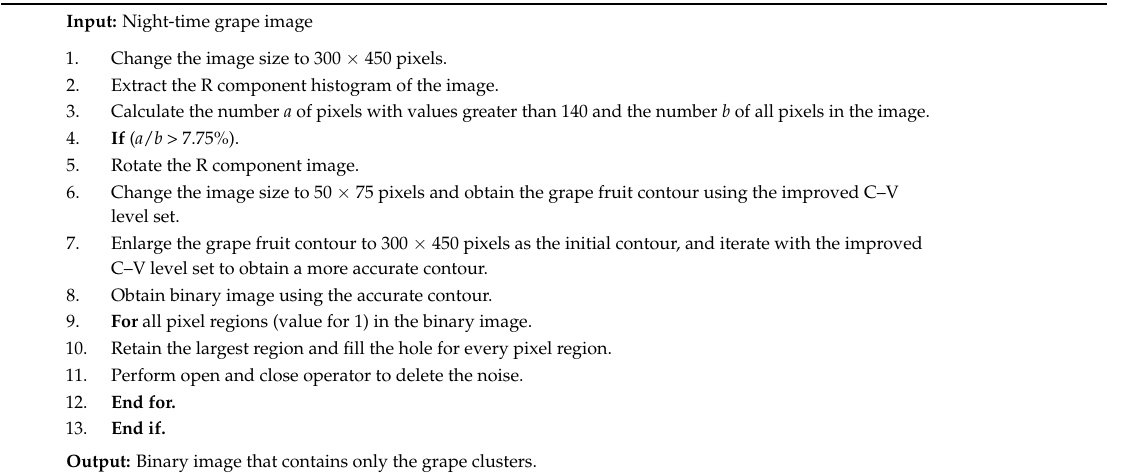
Algorithm 1. The pseudo code of image segmentation and targets extraction Algorithm 1: The pseudo code of image segmentation and targets